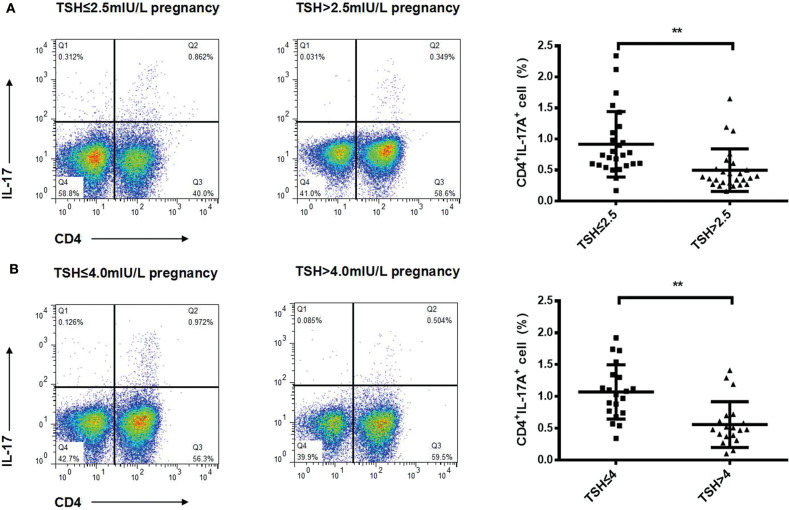
Ratios of Th17 cells decreased progressively with increased TSH concentration in pregnant women during the second trimester. Representative staining of CD4lymphocytes for intracellular IL-17A in pregnant women with TSH levels ≤ 2.5 mIU/L (n = 26), >2.5 mIU/L (n = 26) (A), ≤ 4 mIU/L (n = 20), and >4 mIU/L (n = 20) (B). The percentages of CD4+ T cells expressing IL-17A are shown as individual dots for the two groups. The significance levels of differences between the groups in each subset were analyzed using the t-test (**P < 0.001).